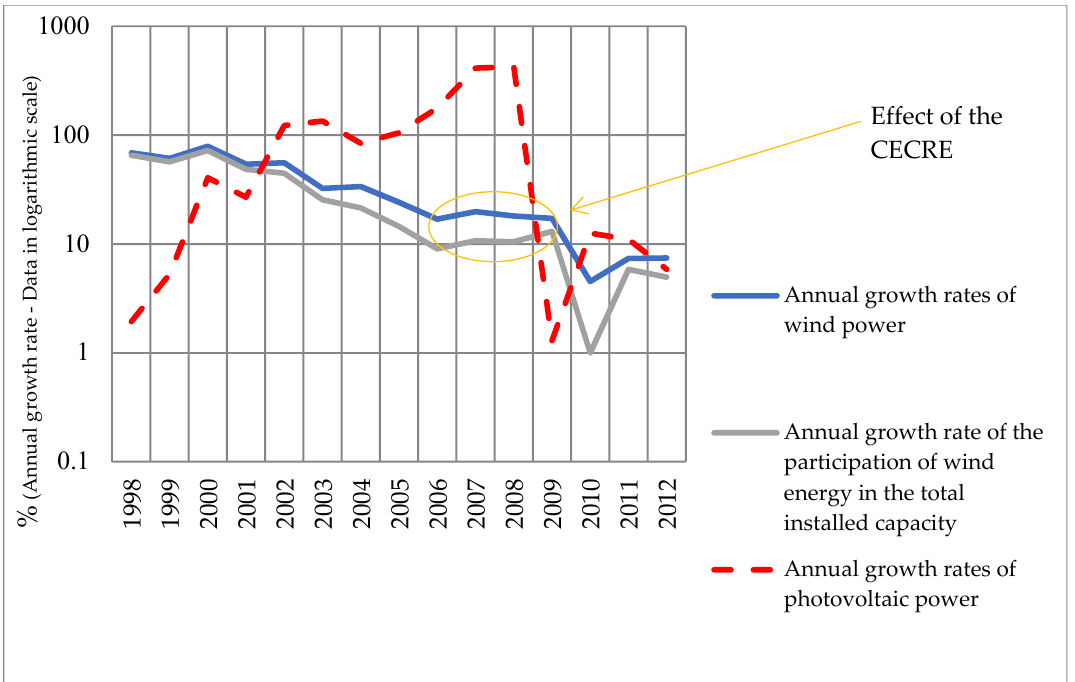
Figure 5. Annual growth rates of wind and photovoltaic power installed capacity. Source: REE data.